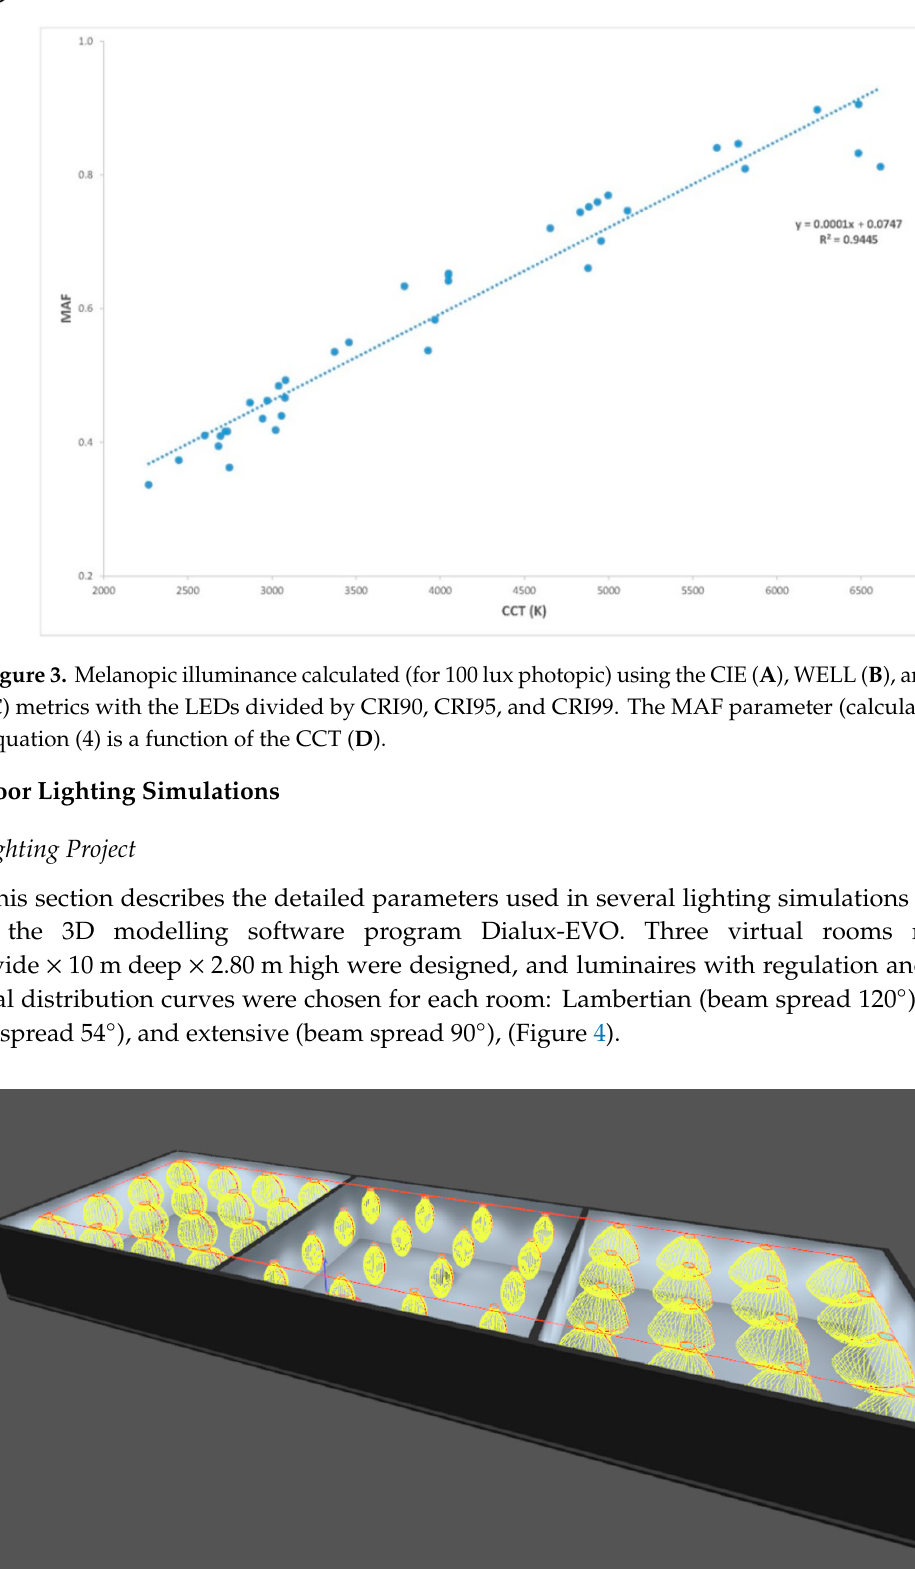
Figure 4. Designed rooms. Left, Lambertian luminaire (beam spread 120°); middle, intensive luminaire (beam spread 54°); right, extensive luminaire (beam spread 90°).